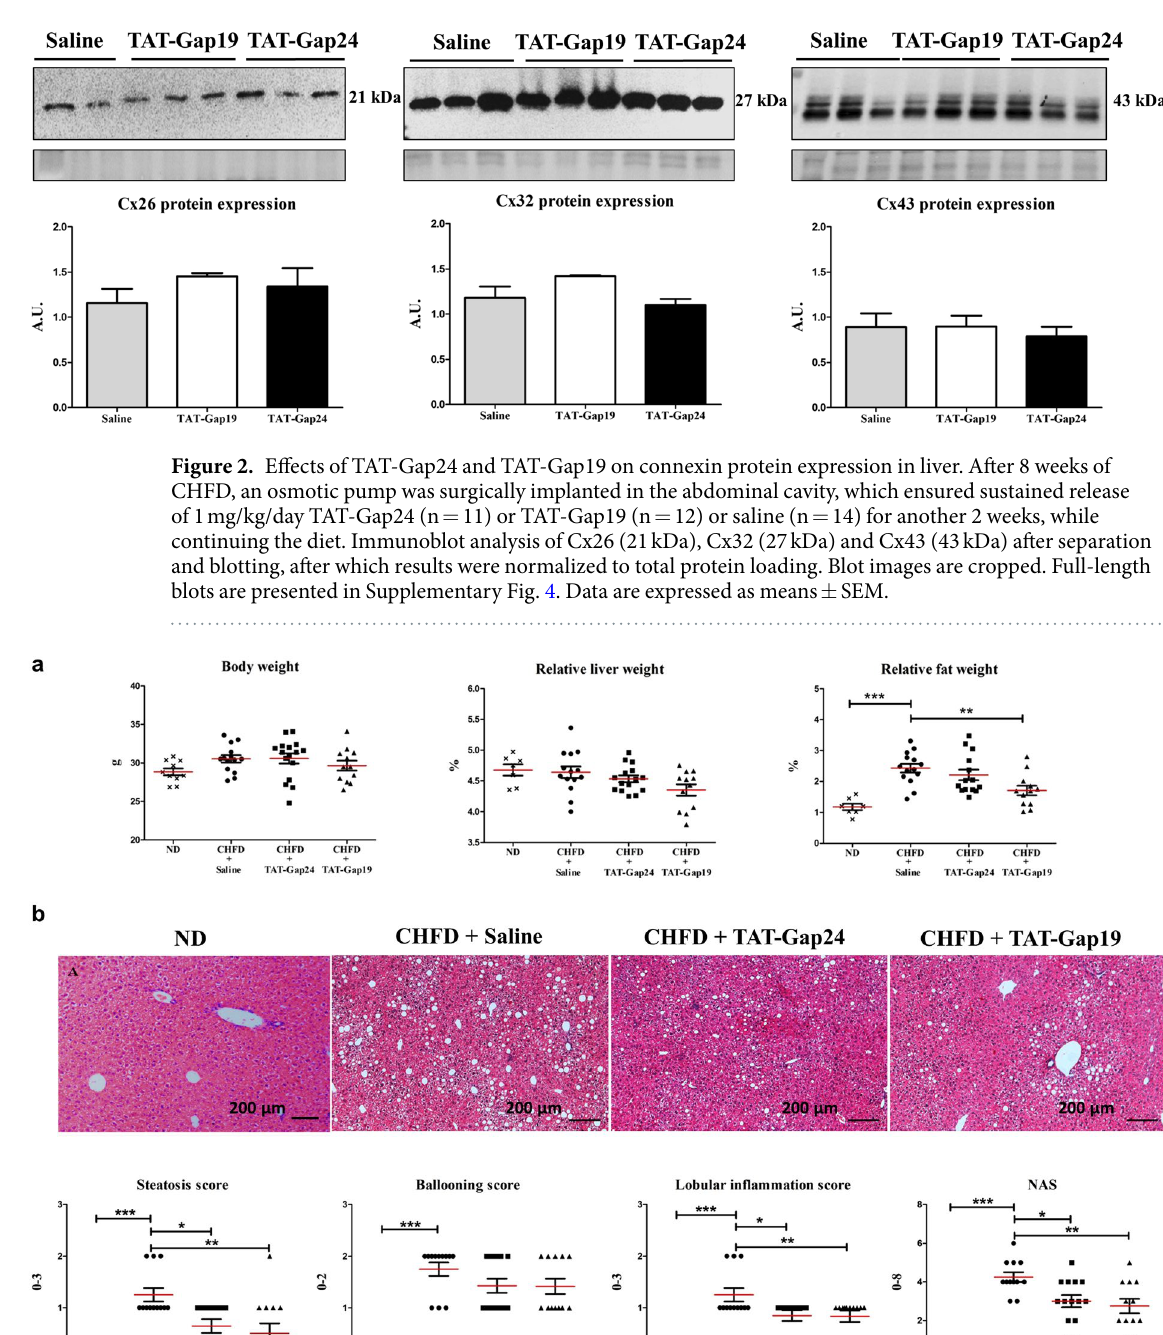
concentrations in treated animals (Fig. 4b).